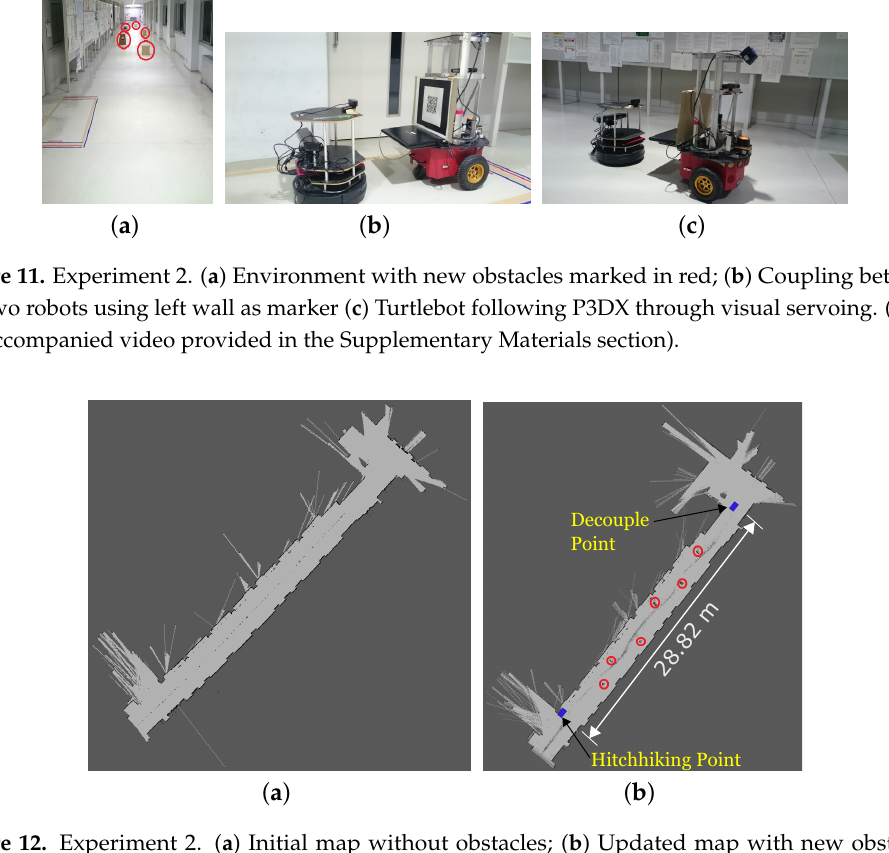
Figure 12. Experiment 2. ( a ) Initial map without obstacles; ( b ) Updated map with new obstacles. Driver robot transferred the obstacle coordinates (marked in red) to the